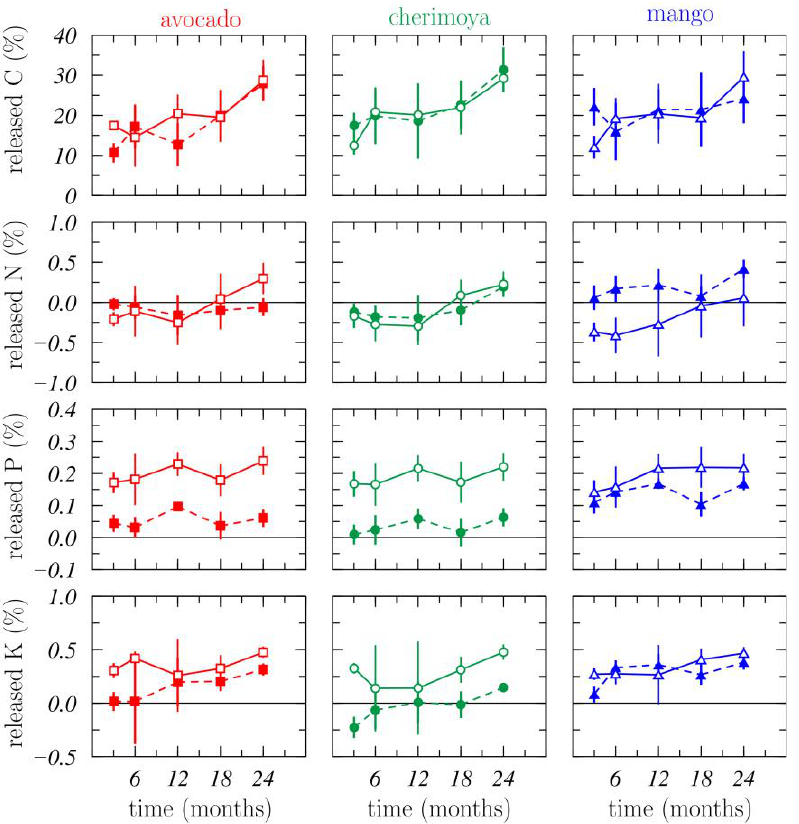
Figure 3. Release of C, N, P, and K at each sampling period (3, 6, 12, 18, and 24 months). The solid line represents the concentrations of the garden waste and the broken line the concentration of the subtropical waste in the respective tree.